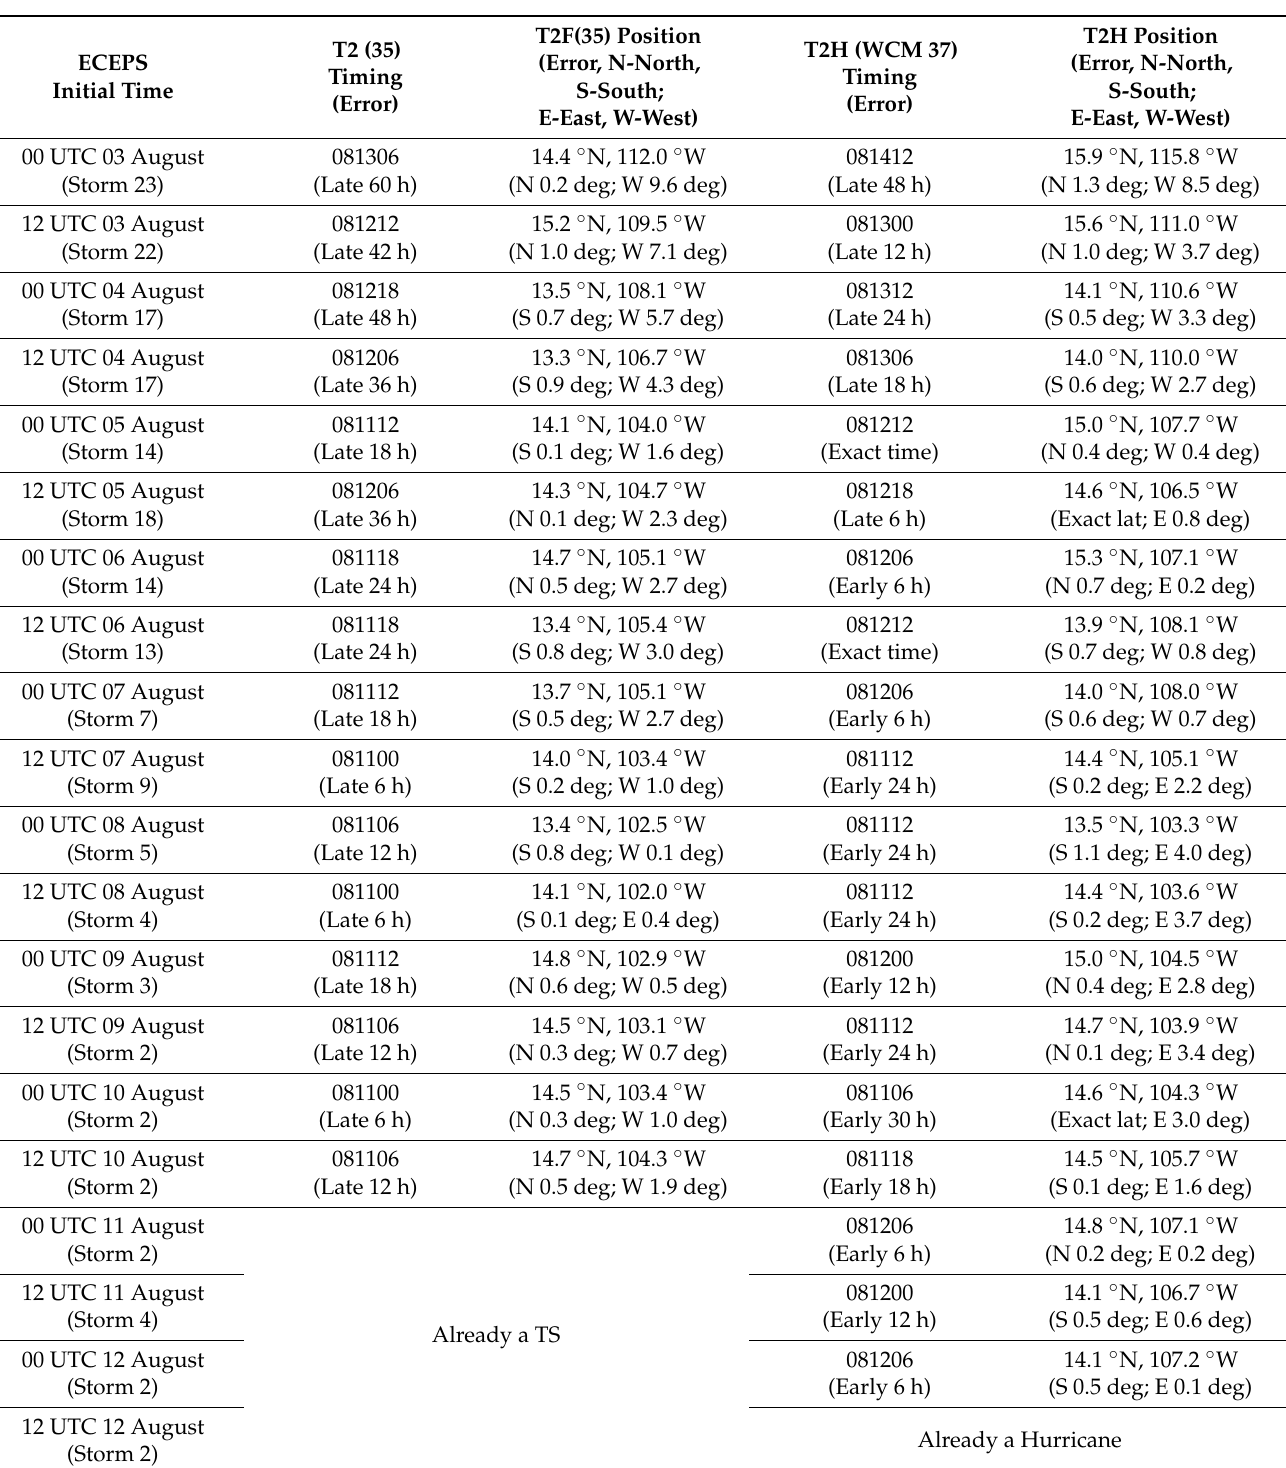
Table 2. ECEPS Timing and Position Predictions of T2F(35) and T2H during